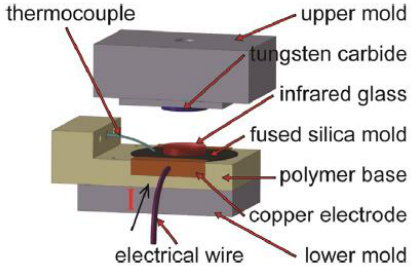
Figure 30. The localized rapid heating molding assembly [65].